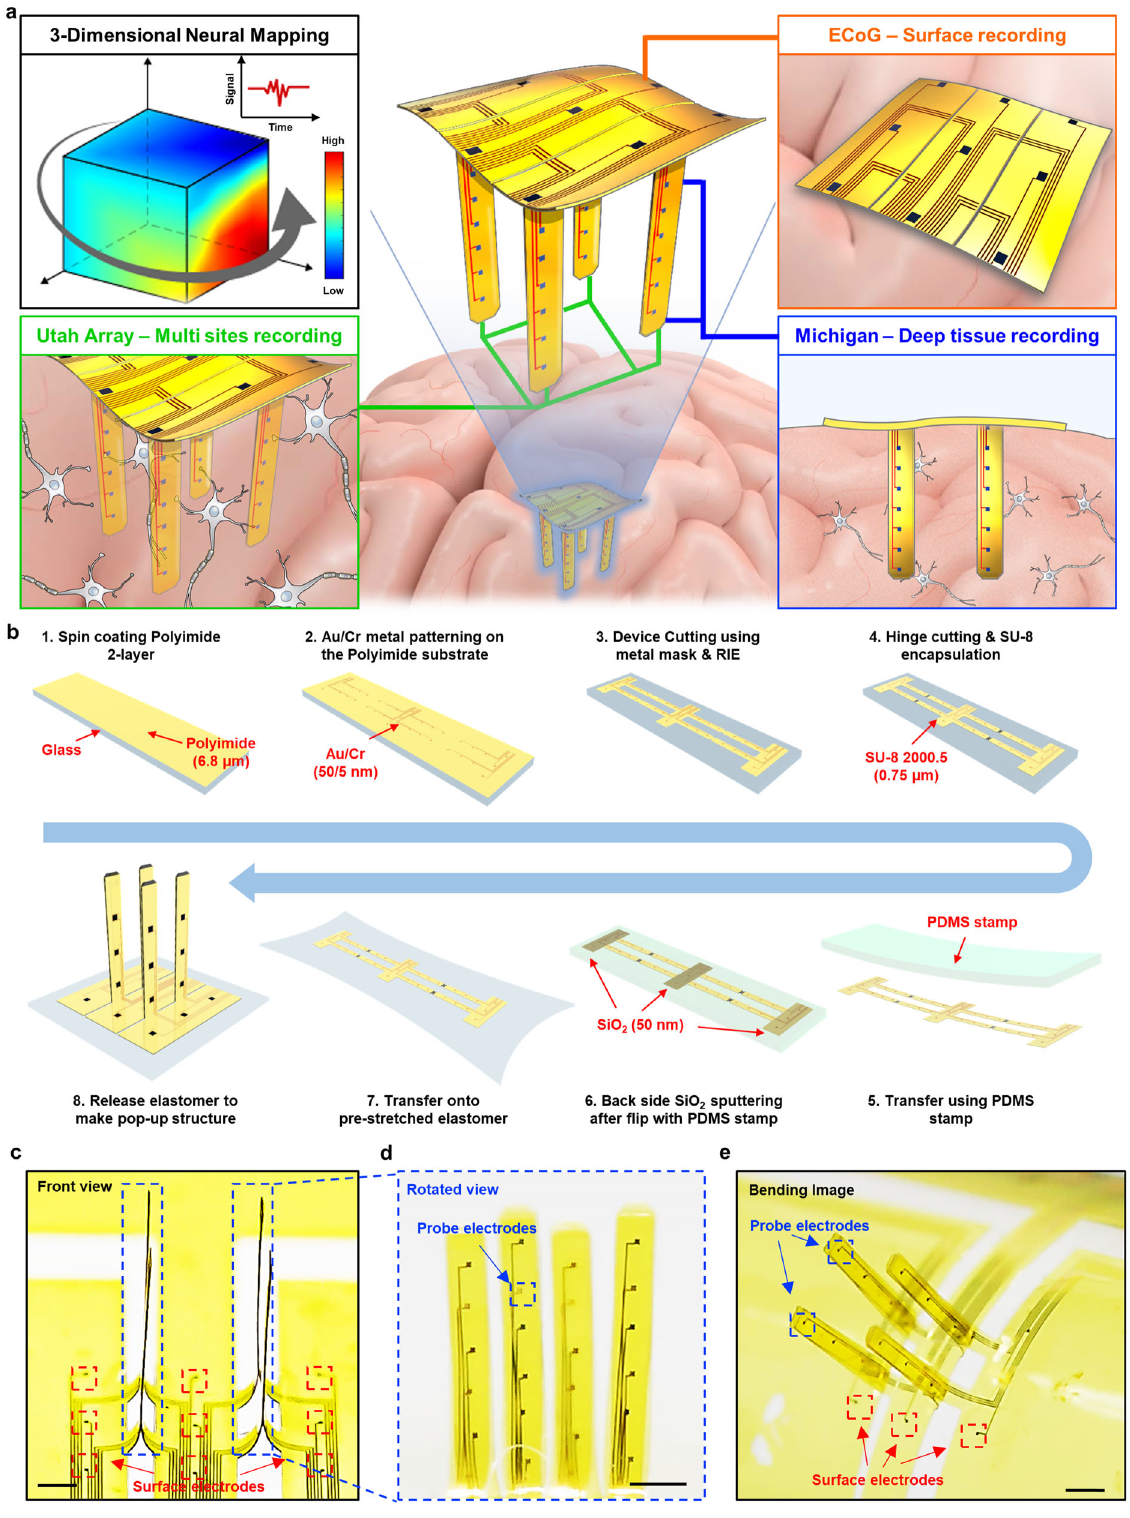
Fig. 1 Foldable and Flexible three-dimensional (3D) neural electrode array for brain mapping both surface and intracortical multi-layer. a Illustration of a 3D brain neural mapping device that is integrated from conventional 2D neural devices (ECoG, Utah array, and Michigan probe). b Flexible 2D fabrication process on a rigid substrate for the preparation of 3D pop-up structure (Steps 1 – 4) and the transformation from 2D planar-type into a 3D structure by pop-up process (Steps 5 – 8). Photographs of the front view ( c ) and the rotated view ( d ) of the 3D neural mapping device consisting of 9 electrodes of ECoG and 4 probes with 6 electrodes for each probe. Each electrode has a recording site of 20 × 20 µm 2 with 500 µm intervals for the ECoG electrodes and 200 µm intervals for the probe electrodes. Each probe is ~1.5 mm in height with a thickness of <20 µm including both sides of the folded fl exible substrates, scale bar, 250 μ m. e Photograph of a foldable and fl exible 3D neural mapping device wrapped around a glass rod with a radius of 5 mm, scale bar, 500 μ